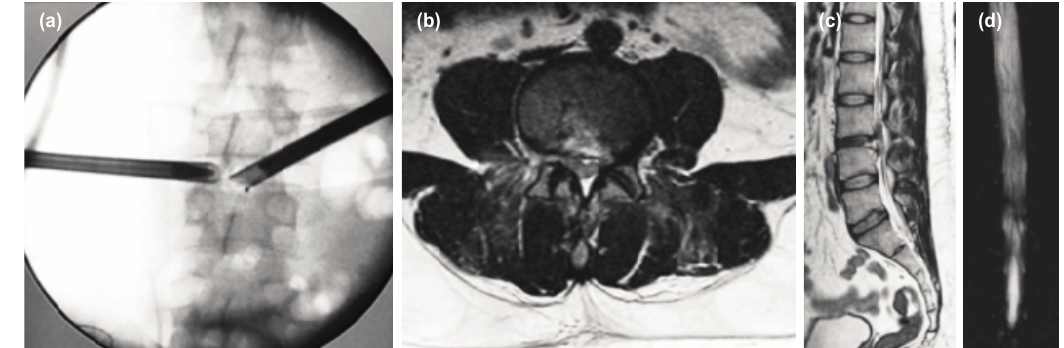
(a) “Inside out” Bi-lateral Bi-portal approach taken for surgery. (b,c) Post-operative T 2 axial and saggital MRI showing complete Fig. 4: decompression. (d) MR myelogram shows blockage cleared and the patient recovered within one